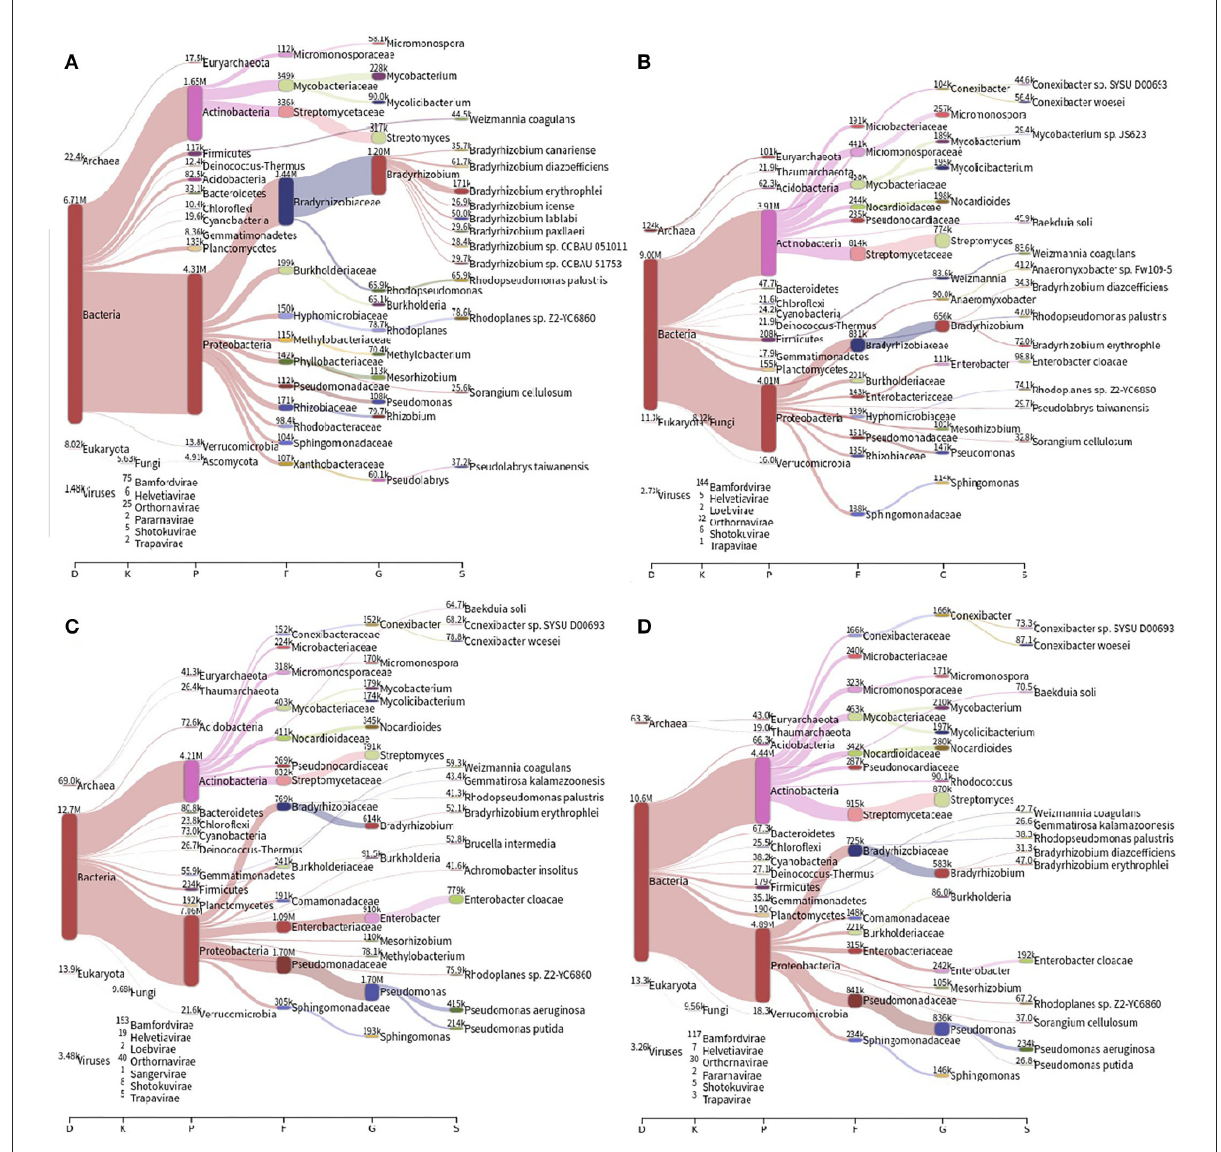
FIGURE1 Distribution of the different bacterial taxonomic groups identified in the soils of (A) forest, (B) pasture, (C) 2-years soybean monoculture, and (D) 14-years soybean monoculture. The number of readings is classified as K, kingdom; P, phylum; F, family; G, genus; S, species.